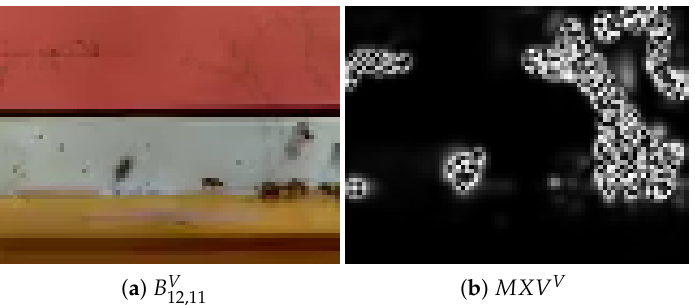
Figure 7. Background frame B V ( a ) for 12 frames of video V in Figure 2 and ( b ) corresponding 12,11 MXV V for V that holds values and positions of highest color variations across all 12 frames in V ; value of CLV V computed from MXV V is 13.59; value of Θ V is 11.35; Θ V is computed by Γ function in Equation (33) in Section 4.2.